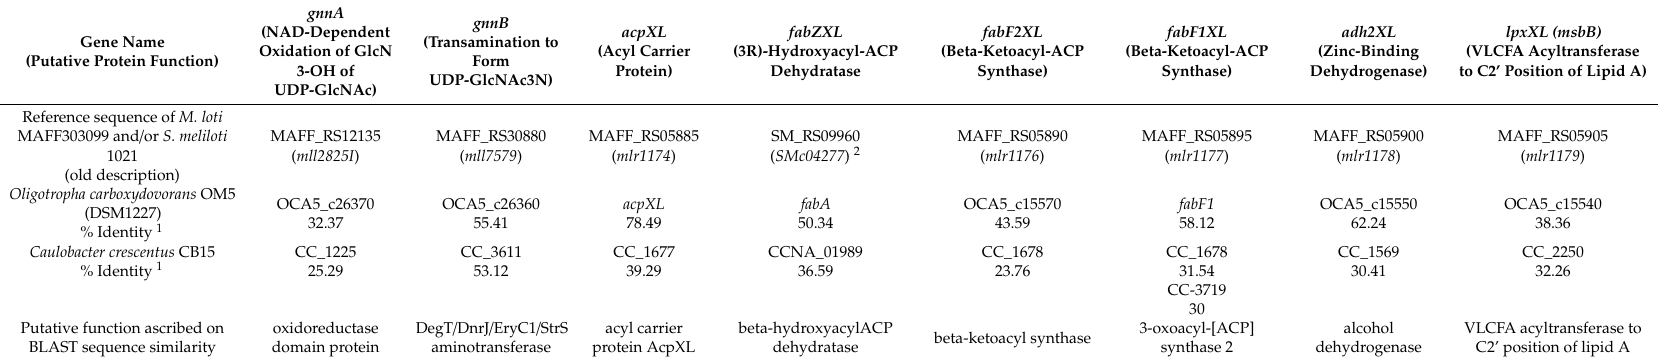
Table 5. Sequence similarity of putative proteins involved in lipid A modification in Oligotropha carboxidovorans OM5 and Caulobacter crescentus CB15 with enzymes of known functions from the reference strains: Mesorhizobium loti MAFF303099 and Sinorhizobium meliloti